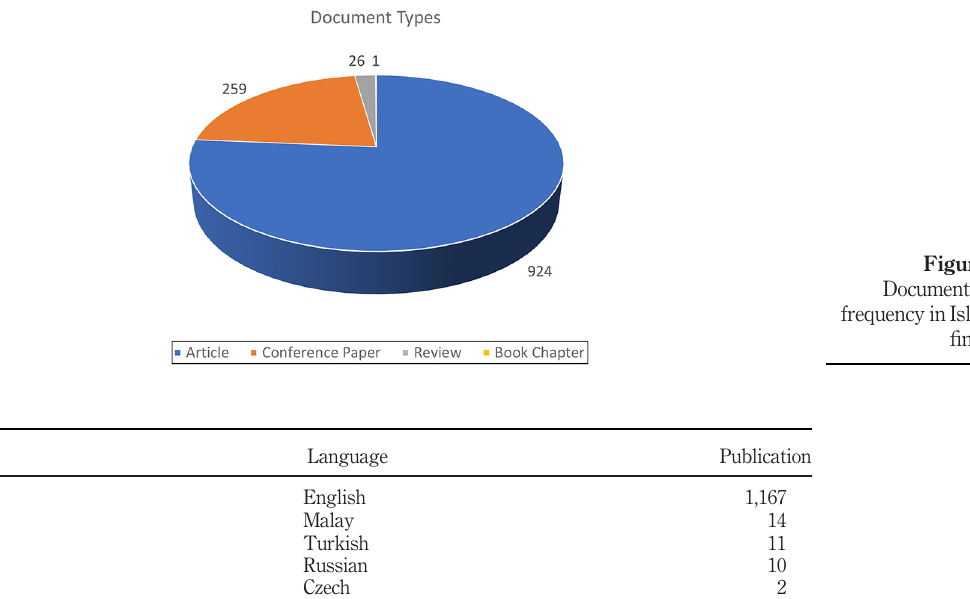
Table 7. Language as